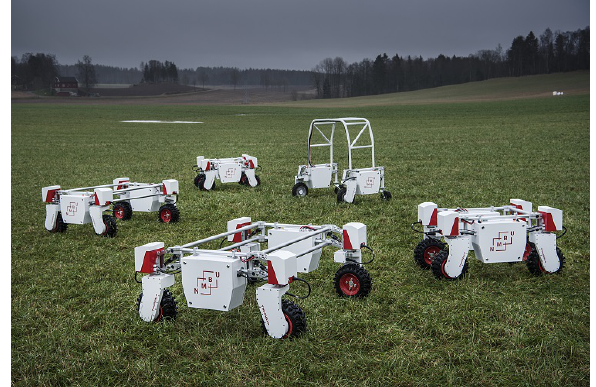
Figure 1: A handful robots created from Thorvald II mod- ules. The tall robot in the background on the right has a custom frame made from welded steel pipes.